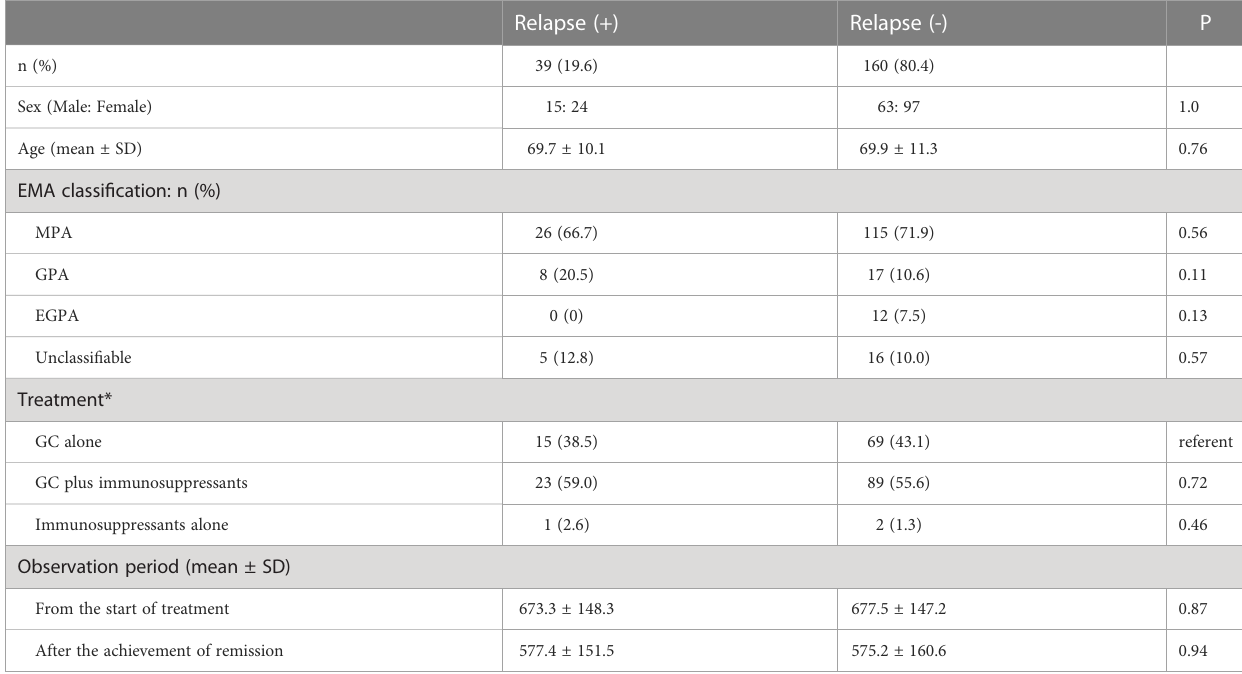
TABLE 3 Characteristics of the MPO-ANCA single-positive AAV with and without relapse.